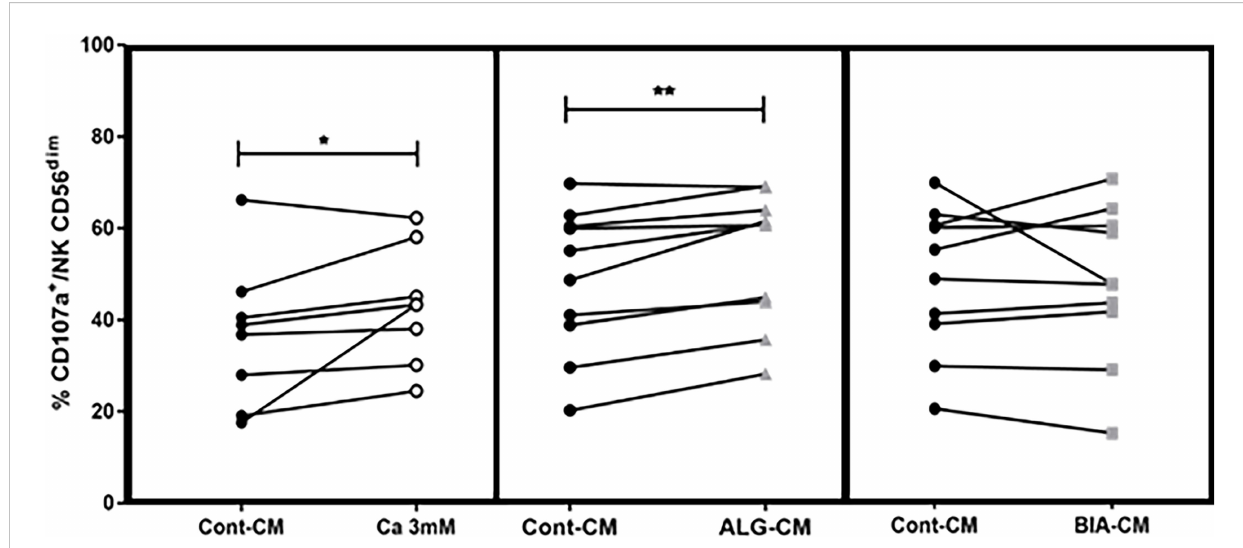
FIGURE 2 Degranulation of NK cells. The CD107a surface expression was assessed on viable CD56 +dim cytotoxic cells by fl ow cytometry after NK cells incubation with K562 cells at a 1:1 ratio for 18h in the presence of CaCl 2 solution at 3mM (white circle, left side), ALG-CM (grey triangle, middle), and BIA-CM (light grey square, right side) versus control (black circle). Each line links data from the same donor (n=8 for Ca 3mM; n=10 for ALG-CM and BIA-CM). Statistical comparison of data versus control CD107a expression was assessed using Wilcoxon paired test. * p <0.05, ** p <0.01.